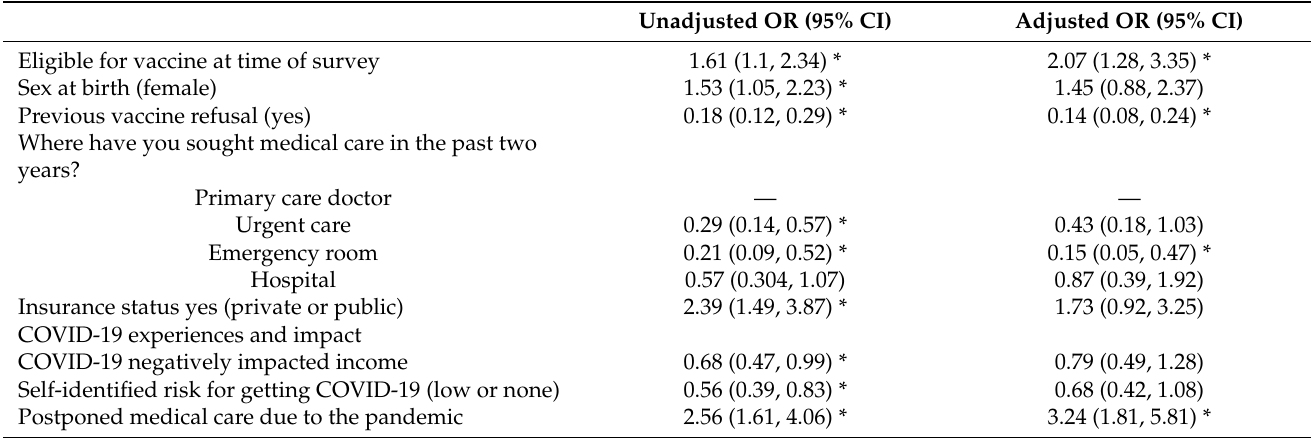
Table 3. Results of Multivariable Analysis of Final Model of Positive Vaccine